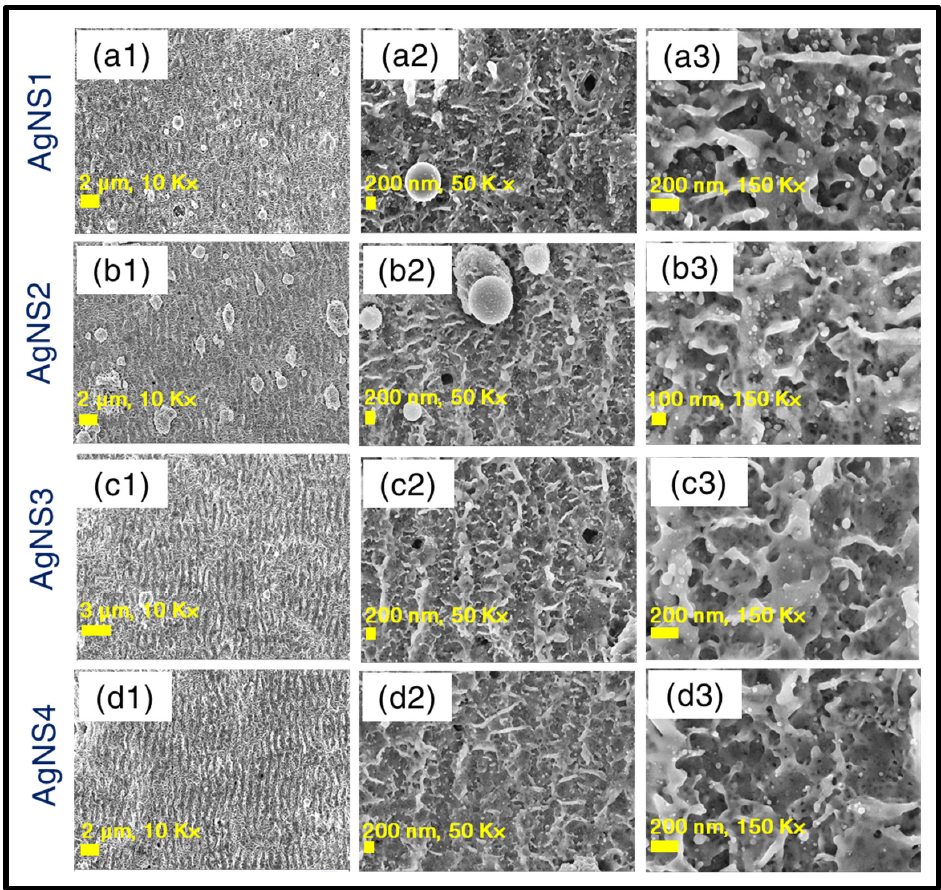
Figure 3. FESEM images for AgNS1 (( a1 – a3 )-12 mJ), AgNS2 (( b1 – b3 )-16 mJ), AgNS3 (( c1 – c3 )-20 mJ), AgNS4 (( d1 – d3 )-24 mJ), respectively. For the four sets of images for each NS, in detail, all figures corresponding to labels (1), (2), (3) illustrate FESEM images with different magnifications of 10 K×, 50 K×, 100 K×, respectively.